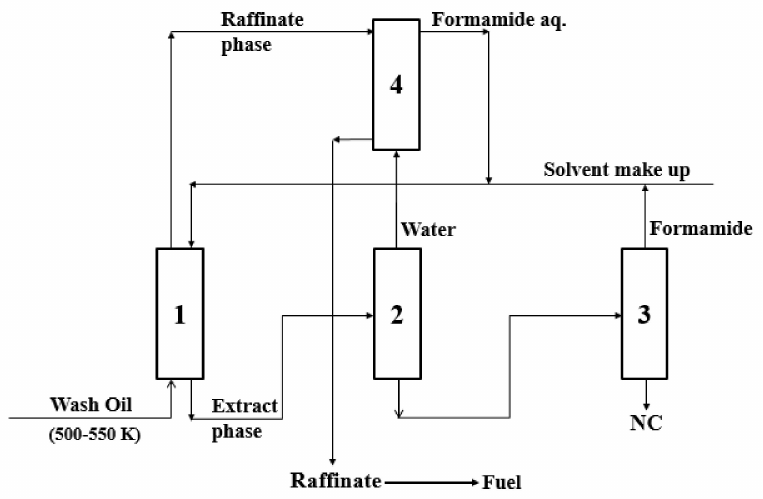
Figure 6. Reduction process of NCs contained in wash oil [2]. Tower no. 1: extraction tower, tower nos. 2, 3: distillation towers, tower no. 4: washing